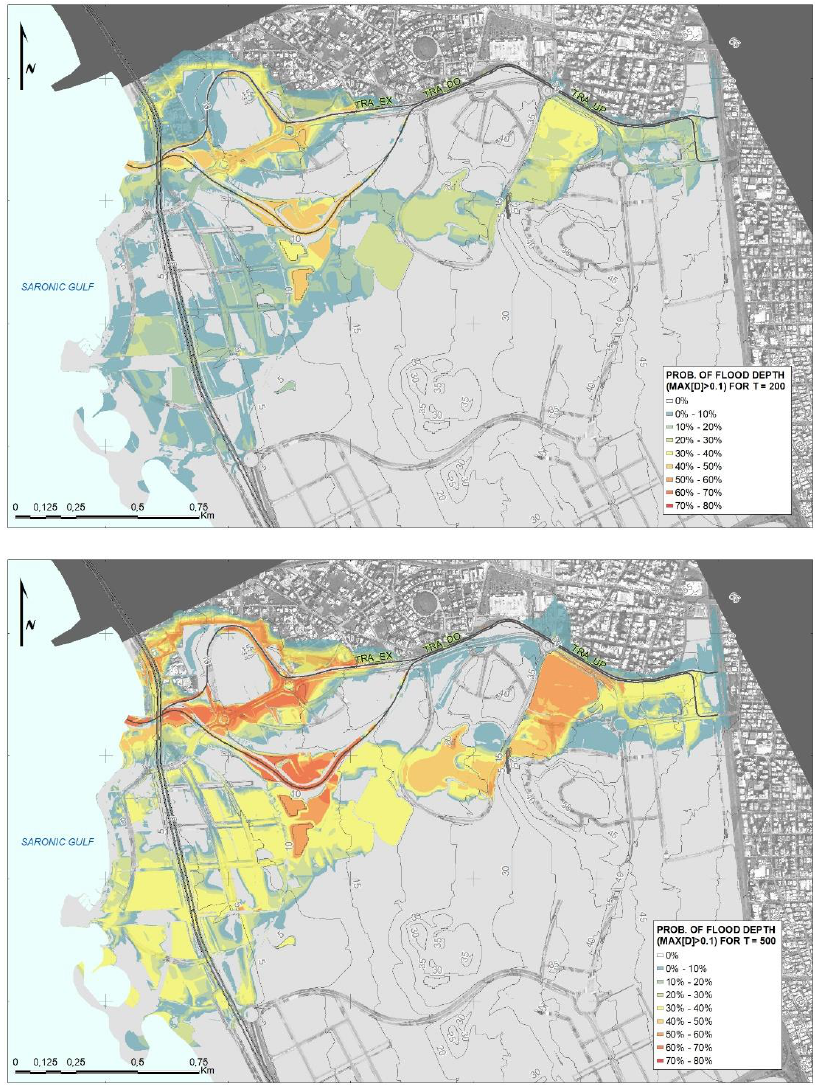
Figure A1. Probability of depth >0.1 m (curb height), for a rainfall event with 𝑇 = 200 years ( top ) vs. 500 years ( bottom ).